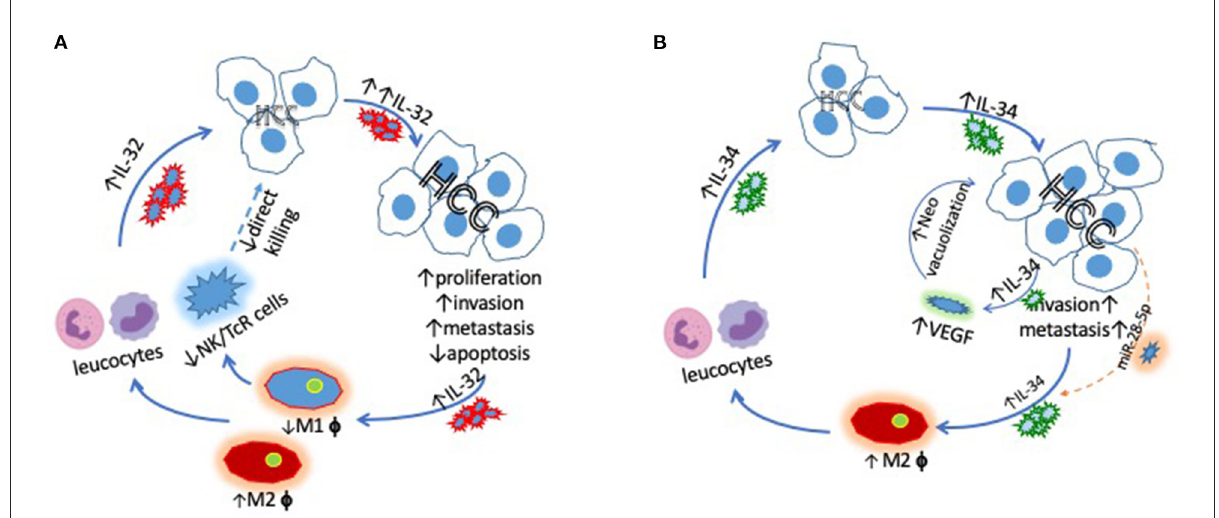
FIGURE1 Schematic demonstrating (A) the key interactions between IL-32 and HCC driving increased HCC proliferation, invasion and metastasis via promoting M2, but inhibiting M1 cells and (B) the links between IL-34 and HCC, which also ultimately lead to increased HCC tumorigenesis. miR-28-5p blocks the pro-tumor effects of